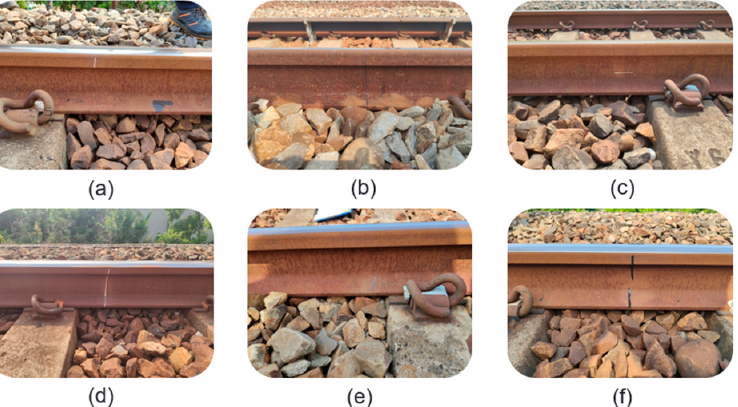
Figure 14. Simulated rail cracks by using (a) aluminum tape on rail head, (b) marker pen to draw, (c) aluminum tape on rail belly, (d) aluminum tape, (e) aluminum tape on rail bottom, and (f) black tape.